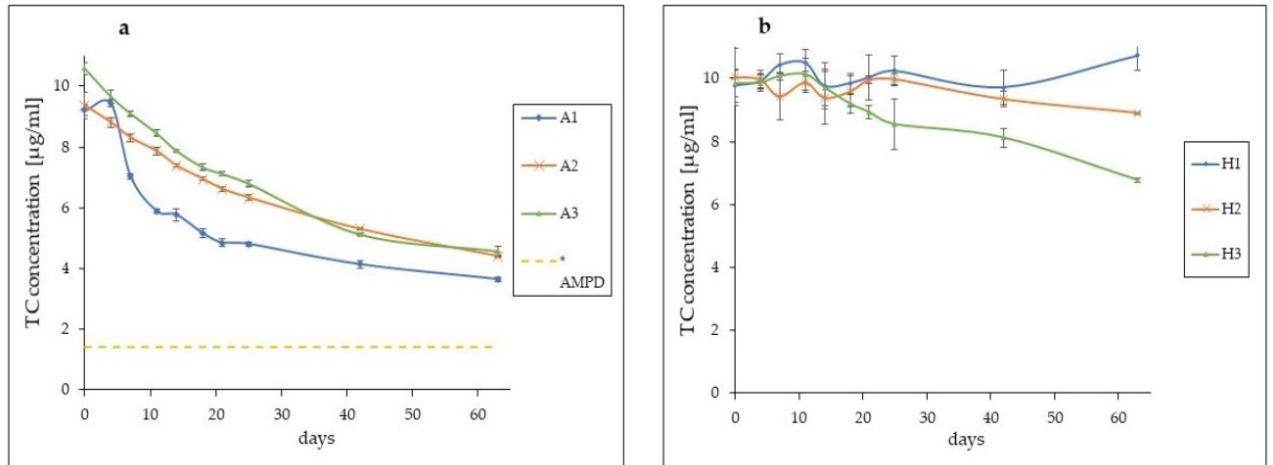
Figure 1. The course of changes of TC concentration. ( a ) changes in aqueous solutions, * the yellow dashed line represents the TC concentration level in the AMPD aqueous solution on 63rd day of observation—1.39 µ g/mL; ( b ) changes in the hydrogel samples.